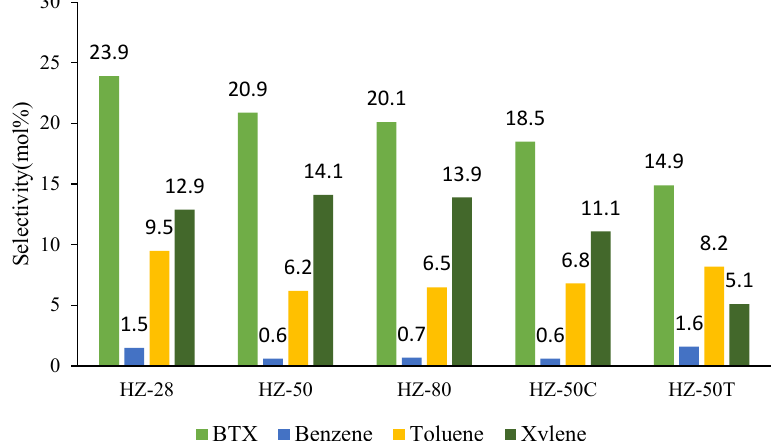
Fig. 8. Selectivity of BTX products in HZ-28, HZ-50, HZ-80, HZ-50C, HZ-50T samples for P = 1atm, T = 400 º C, WHSV = 3 h -1